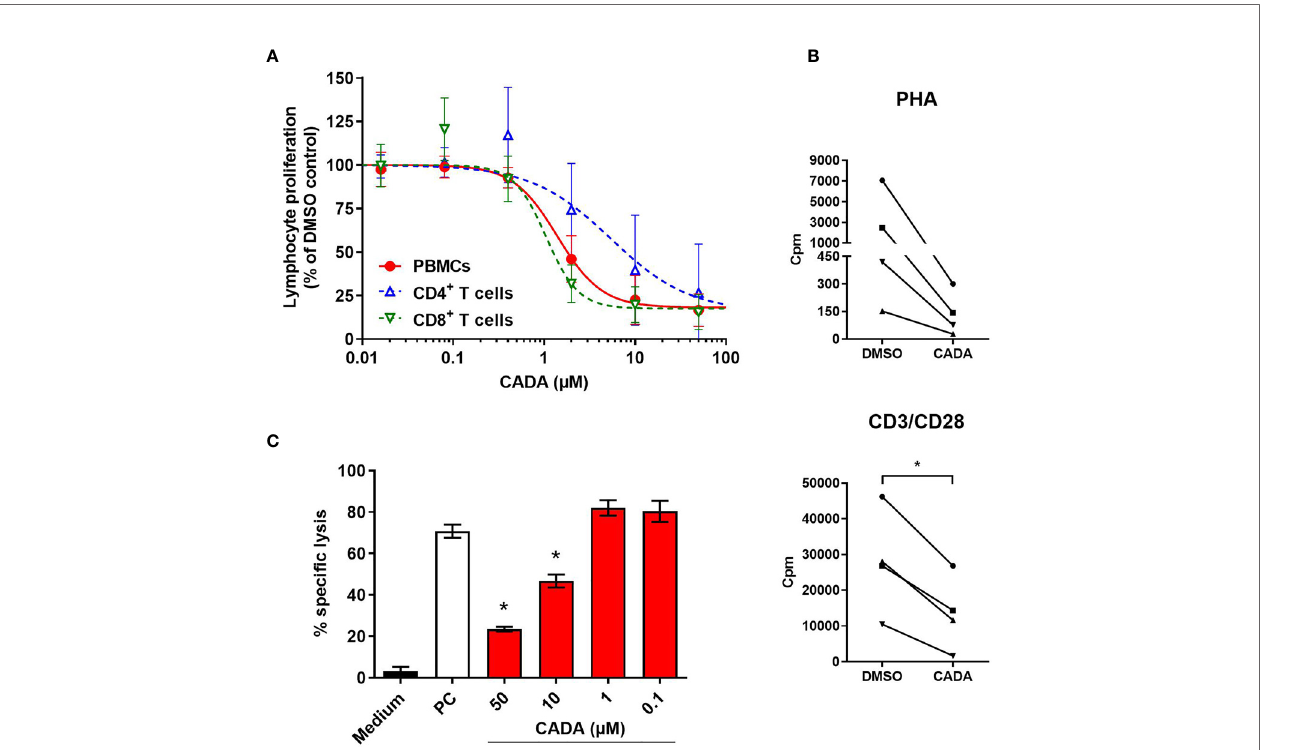
FIGURE 3 | CADA dose-dependently inhibits CD8 + T cell proliferation and cytotoxic T cell function. (A) PBMCs (red), puri fi ed CD4 + T cells (blue) or puri fi ed CD8 + T cells (green) were co-cultured with mitomycin C inactivated RPMI1788 cells in the presence of different doses of CADA. At day 5, [ 3 H]-thymidine was added and proliferation response was measured by detecting counts per minute (cpm) 18h later. Lymphocyte proliferation is given as percentage of the corresponding DMSO control (mean ± SD of six different donors; n=6). (B) Puri fi ed CD8 + T cells were pre-incubated with CADA (10 m M) or DMSO during 3 days, after which they were activated by PHA or CD3/CD28 beads. At 24h post activation, [ 3 H]-thymidine was added and proliferation response was measured by detecting cpm 20h later. Graphs show intra-donor treatment effect on the proliferation response (each donor is indicated separately). A paired t-test was performed to compare CADA to DMSO with *p<0.05; n=4. (C) PBMCs were cultured in medium alone (black) or were co-cultured with inactivated RPMI1788 cells in the absence (white) or presence (red) of increasing doses of CADA during 6 days. Next, PBMCs were exposed to 51 Cr-loaded RPMI1788 cells for 4h, after which supernatant was collected and 51 Cr release was quanti fi ed. To measure spontaneous and maximum release of 51 Cr, medium or saponin was added to the 51 Cr-loaded RPMI1788 cells, respectively. The mean percentage of speci fi c lysis was calculated by using the following formula: % speci fi c lysis = (experimental release – spontaneous release)/(maximum release – spontaneous release) x 100. A t-test was performed to compare CADA to DMSO with *p<0.05. Bars represent mean ± SD of 4 technical replicates of one